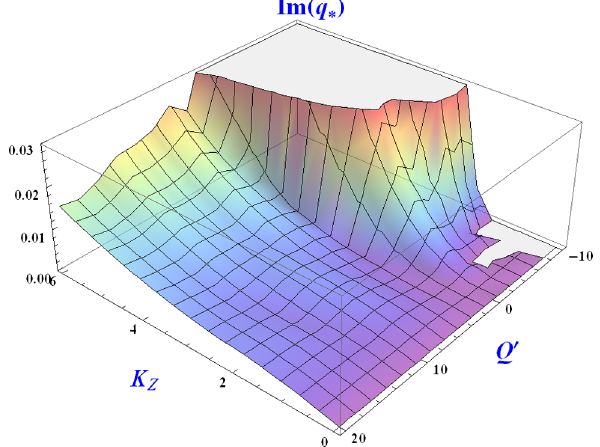
15 (red). The x ¼ FIG. 9. Maximal growth rate versus intensity and chromaticity at the gain g ¼ 1 . 4 .